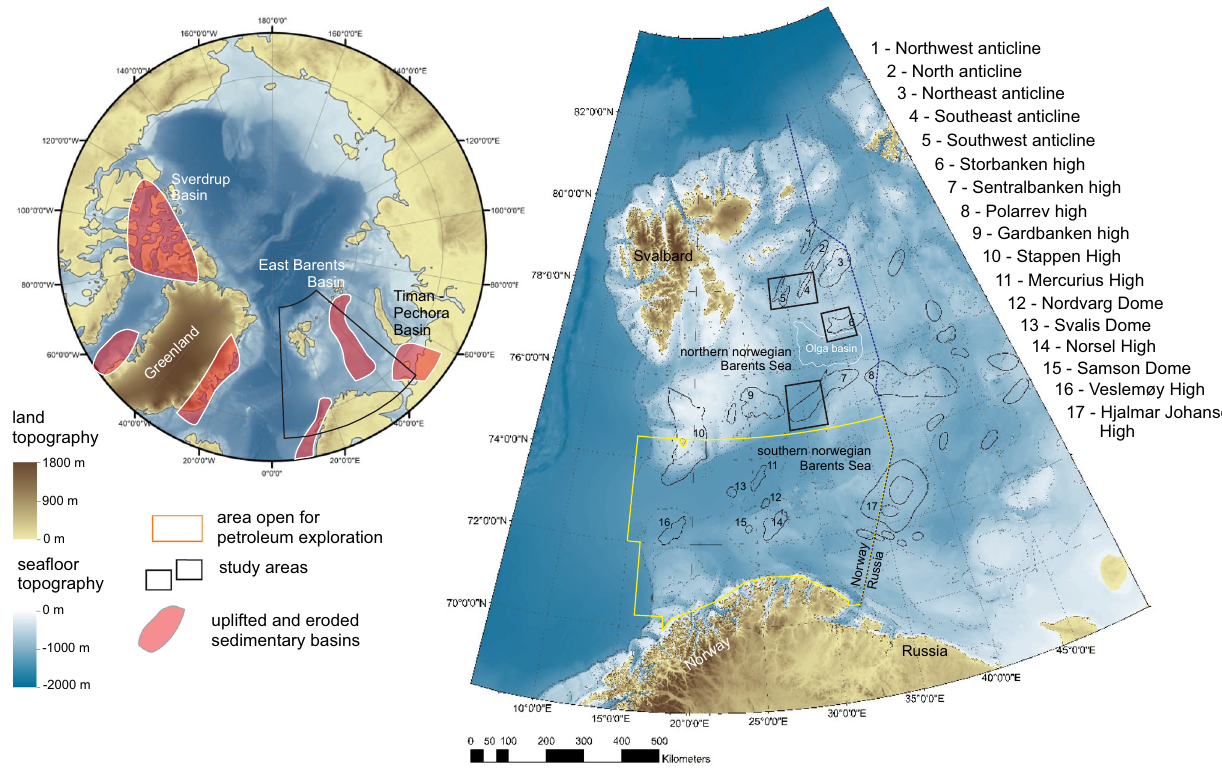
Fig.1|Structuralelements 42 oftheBarentsSeainthecontextoftectonicallyupliftedandglaciallyerodedArcticsedimentarybasins 30,64,66,68,70,83 ,withthenaming conventions following Norwegian Stratigraphical Committee. Bathymetric maps are based on IBCAO V4 data 84